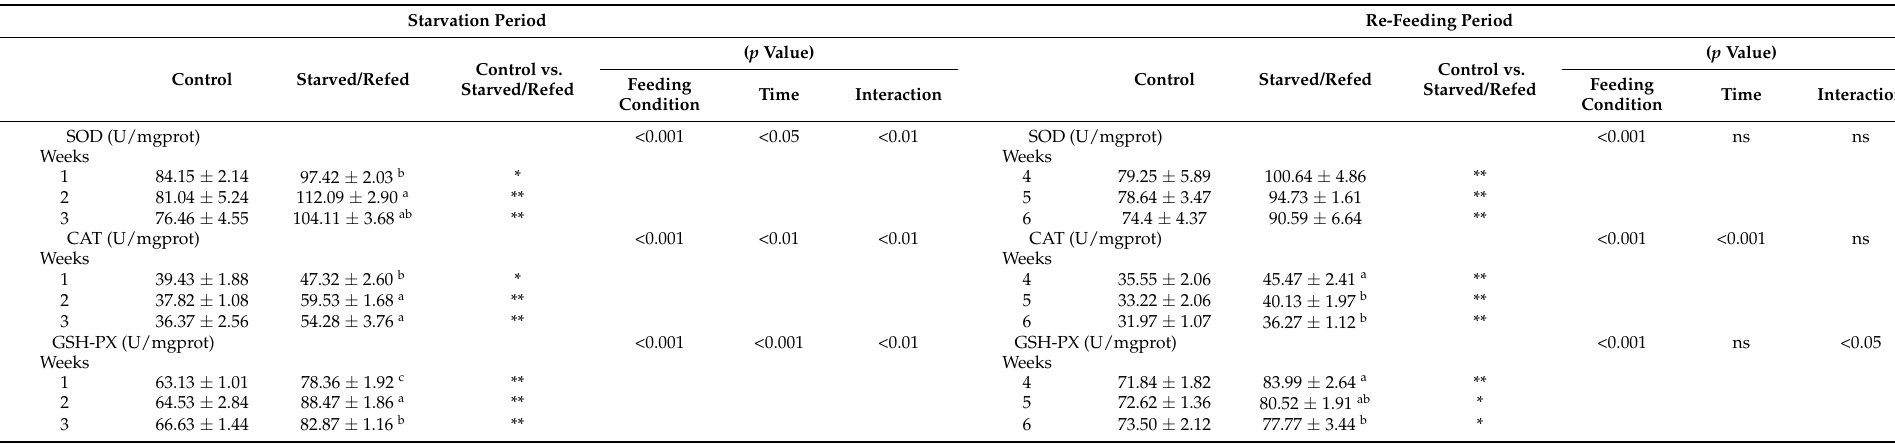
Table 8. Hepatic antioxidant indices of O. macrolepis exposed to starvation and refeeding periods. Starvation Period Re-Feeding Period